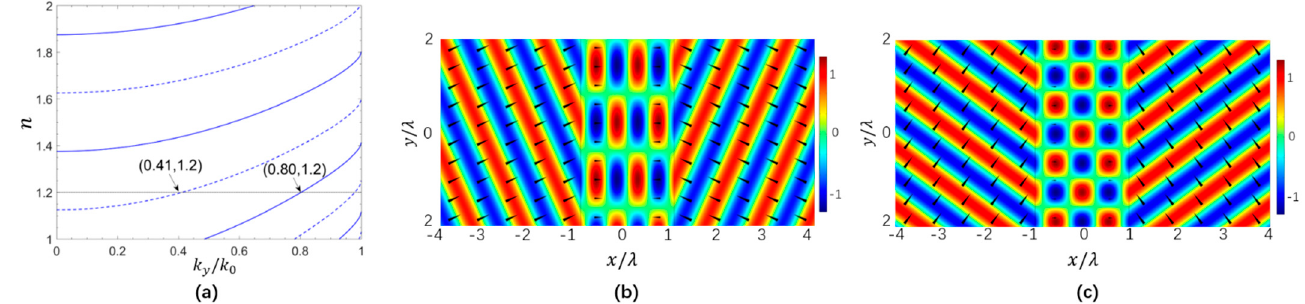
Figure 3. ( a ) The dispersion relation of the CPA mode with the blue solid and dashed curves correspond to the even and odd modes, respectively. ( b ) The acoustic pressure field distribution with bilateral incidences with opposite amplitude, i.e., p fl = − p br = 1 Pa and with incident angle of 24.27 0 . ( c ) The acoustic pressure field distribution with bilateral incidences with equal amplitude, i.e., p fl = p br = 1 Pa and with incident angle of 53.35 0 .